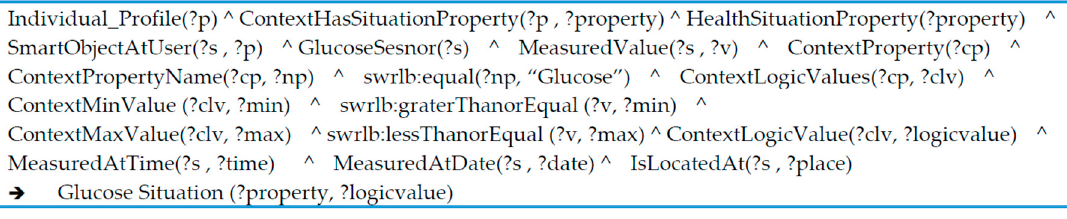
Figure 15. SWRL (A Semantic Web Rule Language) rules for the situation analysis.